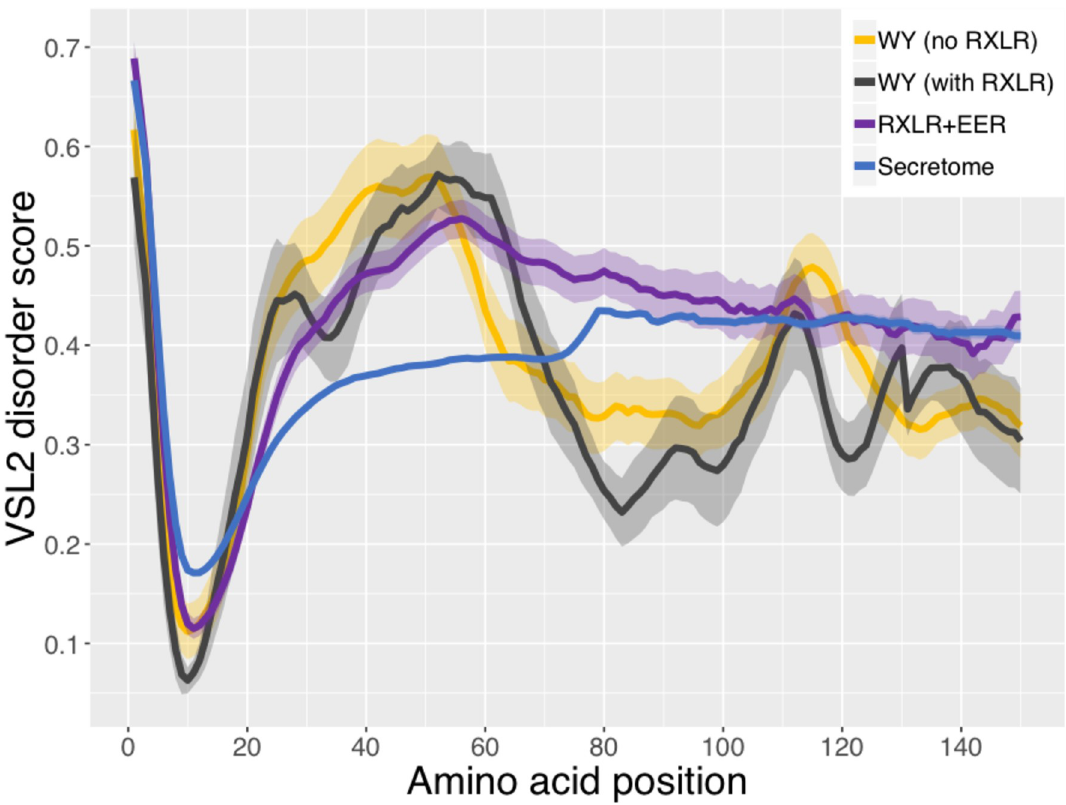
Fig 3. Intrinsic disorder in the first 150 N-terminal amino acid sequences of RXLR and/or WY containing candidate effectors in B . lactucae . Proteins were categorized as WY with no RXLR (yellow), WYs with RXLR (black), RXLR+EER (with or without WY, purple), and the total predicted secretome (blue). RXLR and EER motifs were as described in Fig 2. Average positional disorder scores [46] with standard error are shown for each group of